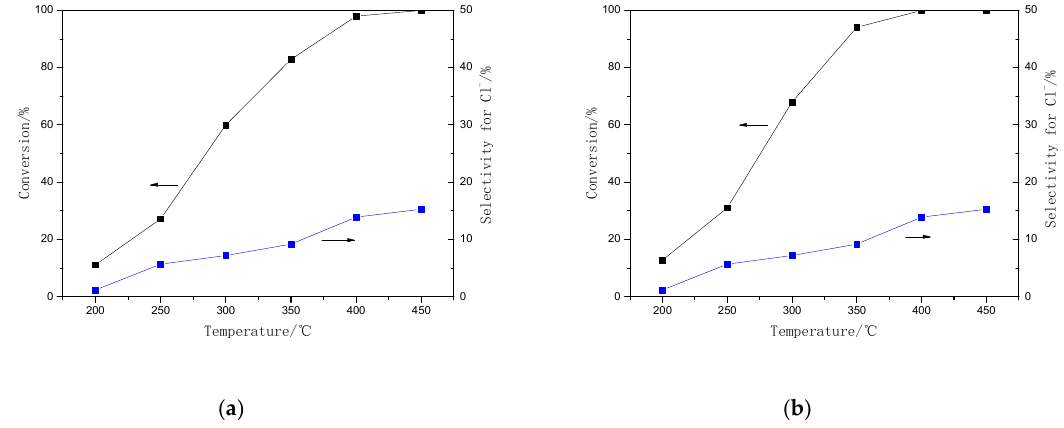
Figure 11. Cl − selectivity over two catalysts. ( a ) 0.2% Pd /TiO 2; ( b ) 0.2% Pd-0.5% Ce/TiO 2